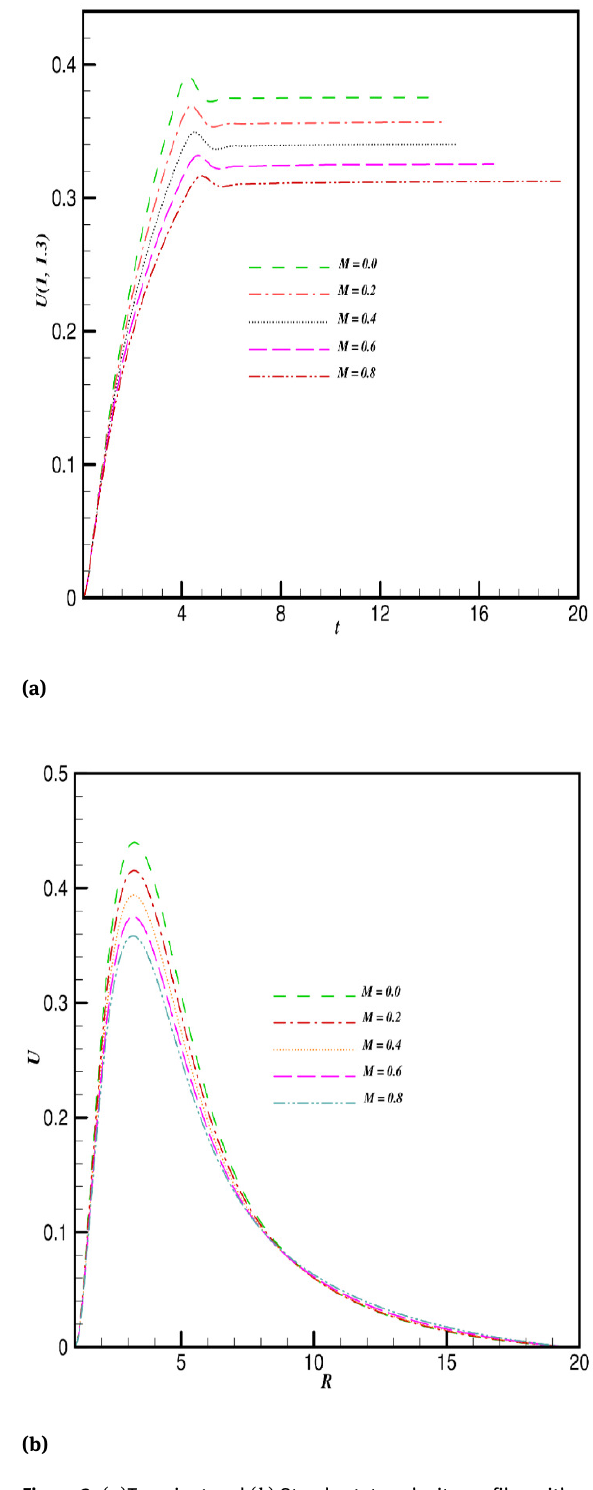
Figure 3: ( a ) Transient and ( b ) Steady state velocity profiles with fixed Sc = 0.6 , Pr = 0.7 , Bu = 1.0 , Kr = −0.2 , Nr = 2.0 , K 1 = 1.0 , Ec = 0.1